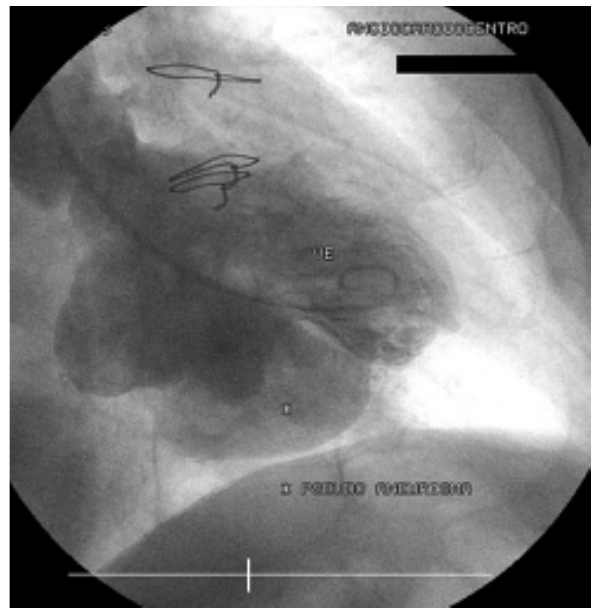
Fig. 1 - Estudo angiográfico demonstrando a coexistência de aneurisma ínfero-basal e grande PsAn em região ínfero-lateral